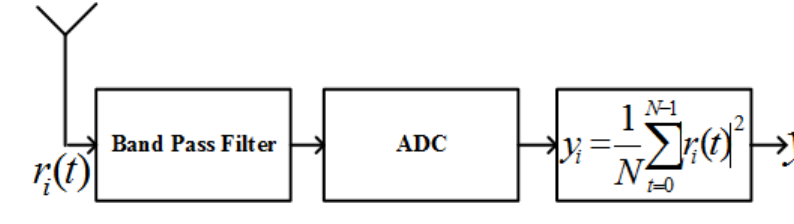
Figure 3. The energy detection